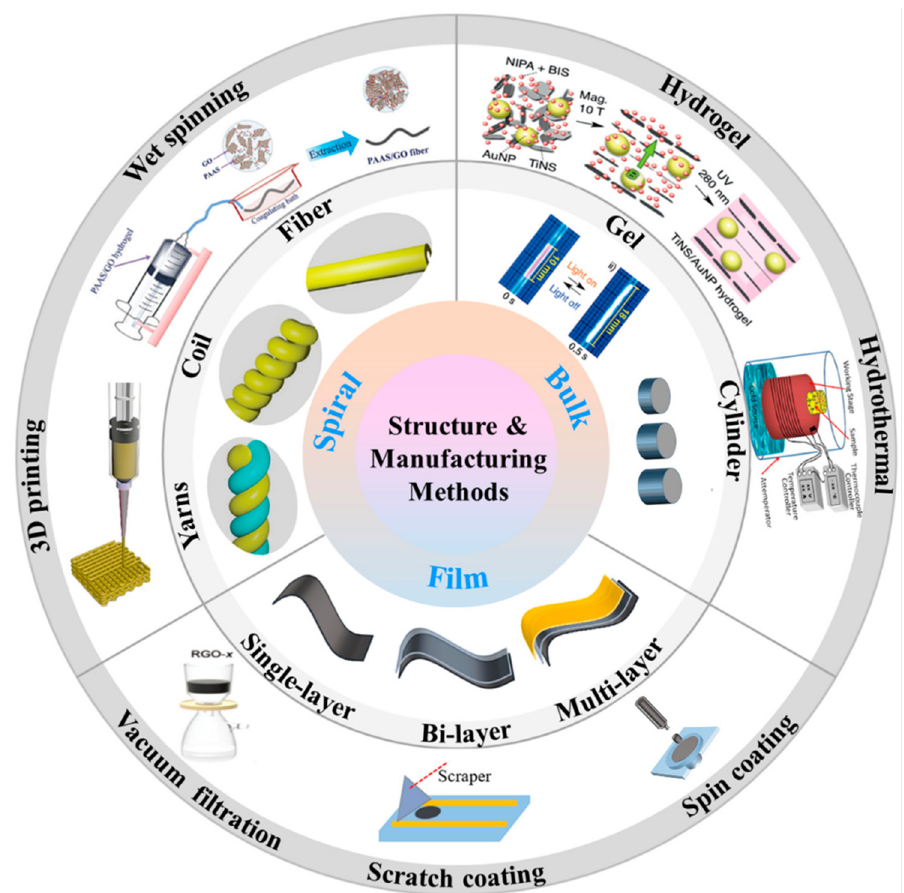
Figure 4. Schematic diagram of the structure and its manufacturing method of the light-responsive actuator. The insets are reprinted from the following sources. Bulk [74]. Permission from Wiley-VCH. Fiber/Coil/Yarns [75]. Permission from Wiley-VCH. Vacuum filtration [76]. Permission from Wiley- VCH. Hydrothermal [77]. Permission from Springer Nature. Wet spinning [78]. Permission from THE